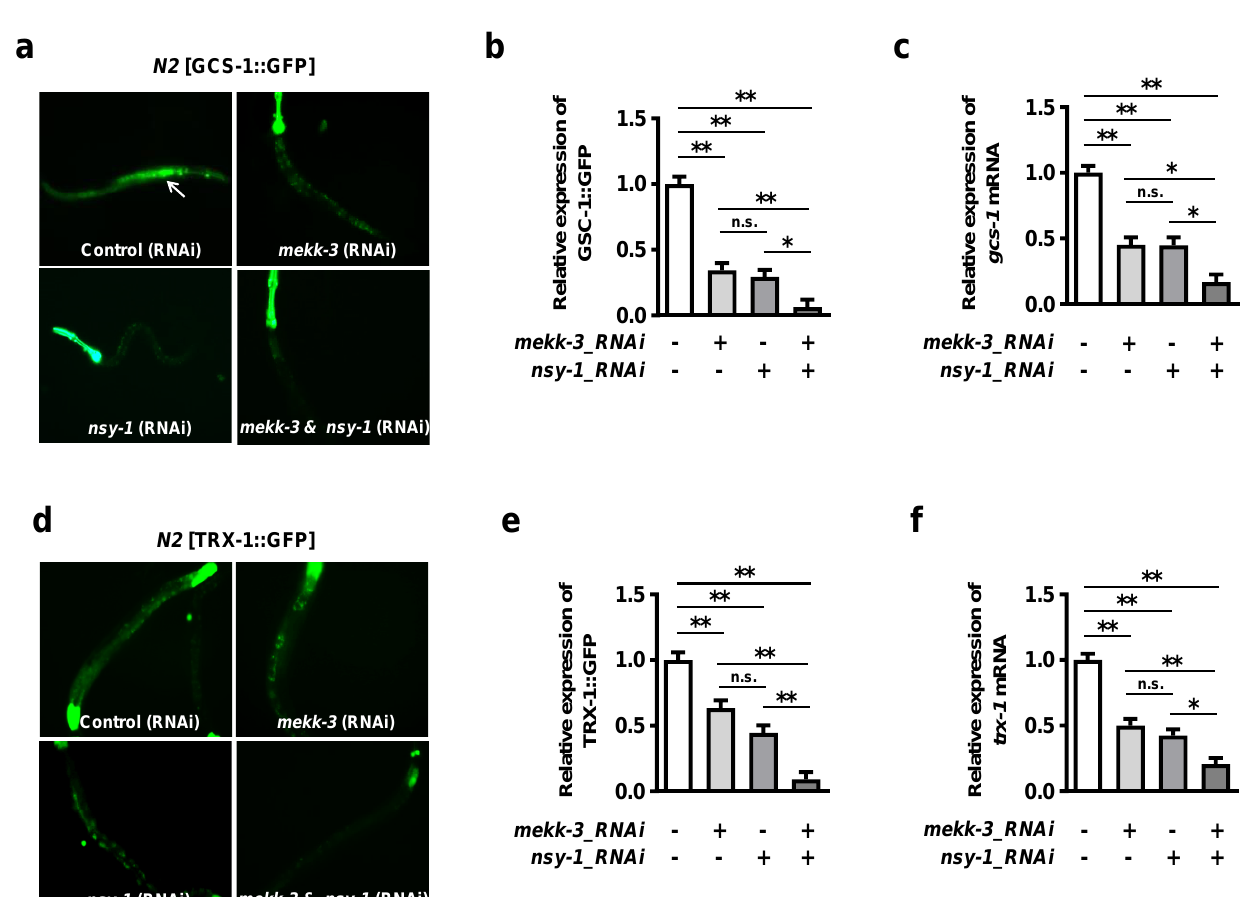
Figure 4. MEKK − 3 and NSY − 1 are indispensable for the induction of SKN − 1 target genes. ( a ) Intestinal expression of GCS-1 labeled with GFP. GCS-1 transgenic young adult worms were fed bacteria that carry RNAi targeting either mekk-3 , nsy-1 , or both mekk-3 and nsy-1 RNAi for 24 h. The L4440 vector without insertion in bacteria was used as a control. Fluorescent images were captured 6 h after the transfer of worms fed RNAi bacteria on 7.5 mM t-BOOH plates. The white arrows indicate